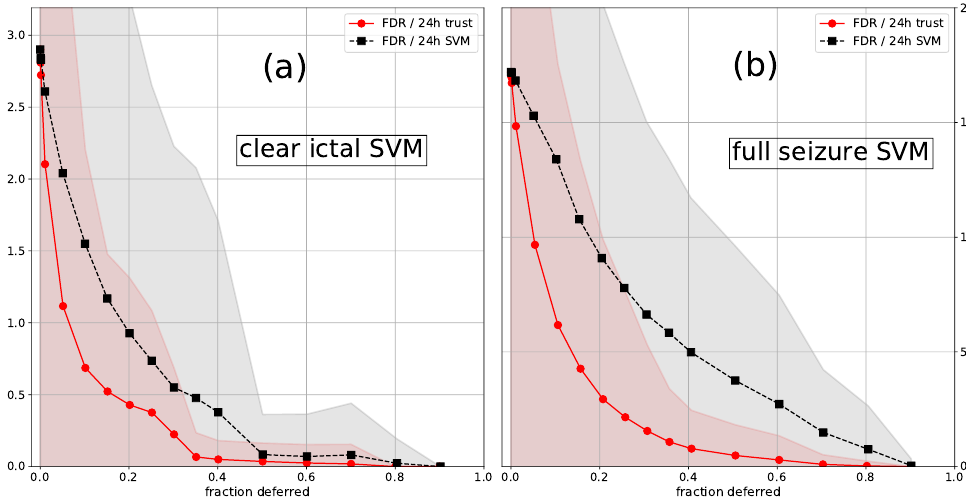
Figure 10. Average FDR/24 h as a function of the fraction of the data that was deferred to a human annotator, for the ( a ) CI SVM; ( b ) FS SVM ( p low = 5). The standard deviation is shown as a shaded area. In contrast to our main approach, the segments that contain seizure flags were not automatically the first to be deferred. Segments were deferred using the SVM confidences (SVM) and trust scores (trust) from a trust model trained on the FS labels (for both